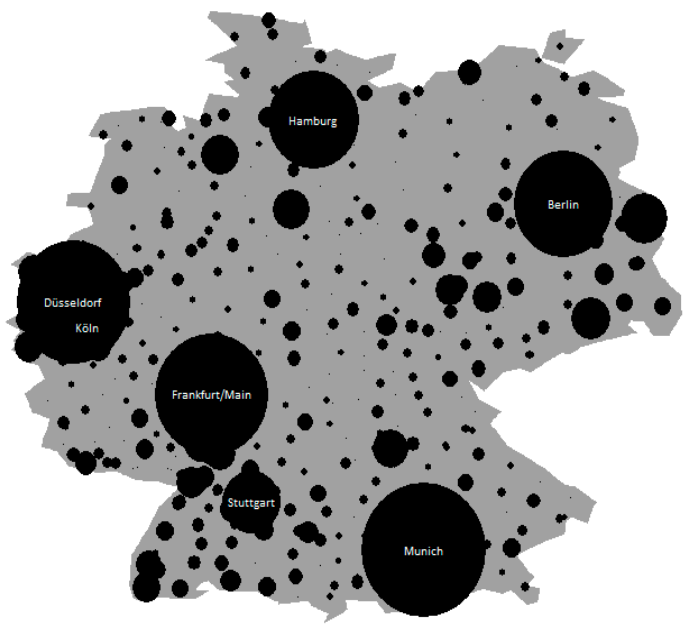
Figure 1. Distribution of greenfield FDI in Germany. Most investments in Germany are made by MNCs based in the United States (29%), United Kingdom (9%), France (7%), Japan (6%), Switzerland (6%), and the Netherlands